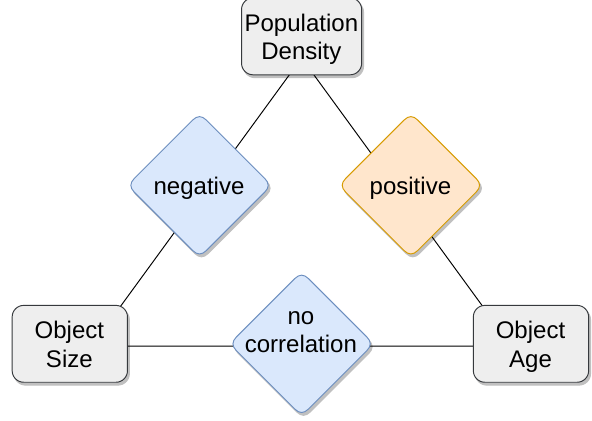
Figure 3. Hypothesised triangular relationship between the object size, the object age and the population density. Interactions that were confirmed by statistical testing are marked in